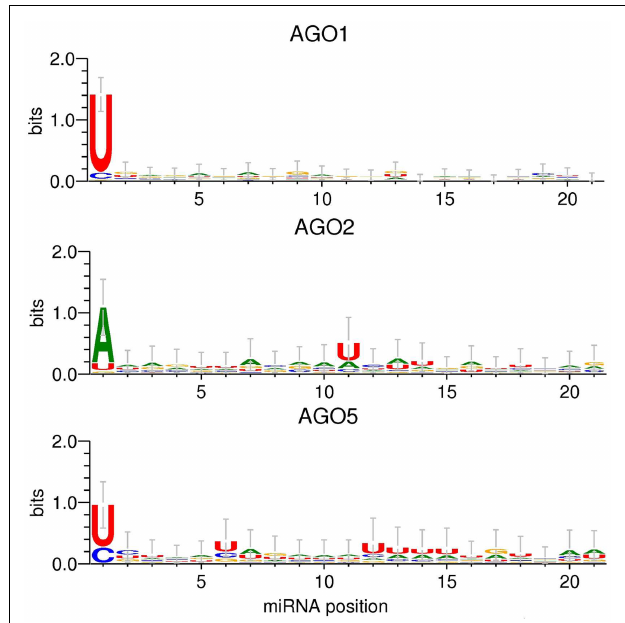
FIGURE 3 | Sequence logo presentations of motifs for miRNAs of the Confidence Set that are preferentially associated withAGO1,AGO2, andAGO5. The height of the stack of symbols or individual base signifies the level of conservation of the given position or base type, respectively, expressed as information contents. Information contents of two bits would correspond to a position exclusively occupied by a single base type. Error bars correspond to Bayesian 95% confidence intervals as estimated by the WebLogo 3 tool (Crooks et al.,